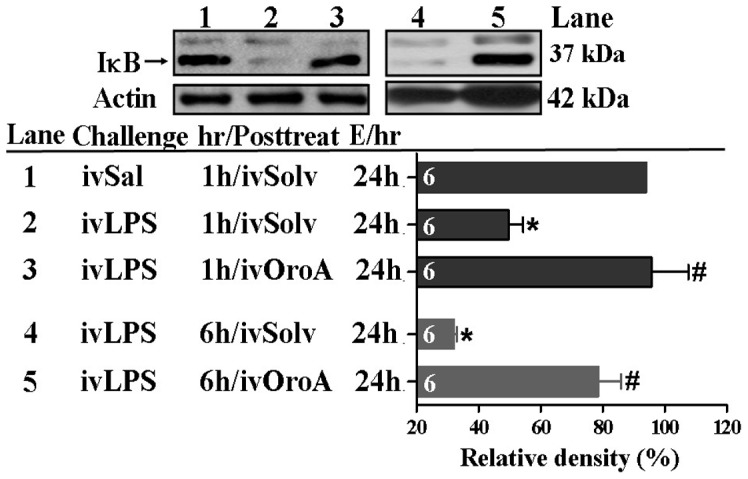
OroA inhibition of LPS-induced IκB degradation in lung tissue.Comparing to control group (Sal followed by Solv-treatment in Lane 1), LPS treatment (10 mg/kg, iv) significantly caused IκB degradation (Lanes 2 and 4). This effect, examined 24 hrs (E/24h) after LPS challenge, was prevented by OroA (15 mg/kg, iv) administered 1 hr (Lanes 3) or 6 hrs (Lane 5) after LPS challenge. The relative percent of total IκB was normalized to actin which served as an internal control, and was summarized as relative density (%). Sal (Saline); Solvent (Solv, normal saline plus Tween 80 at 9∶1 ratio); hr/Posttreat (post-treatment hour after LPS treatment); E/hr (examination hour after LPS challenge). Data are means±SEM. *P<0.05 indicates significant difference from the control (Lane 1). #P<0.05 indicates significant difference from the LPS alone group (Lanes 2 and 4). The number in each column represents the number of rats examined.